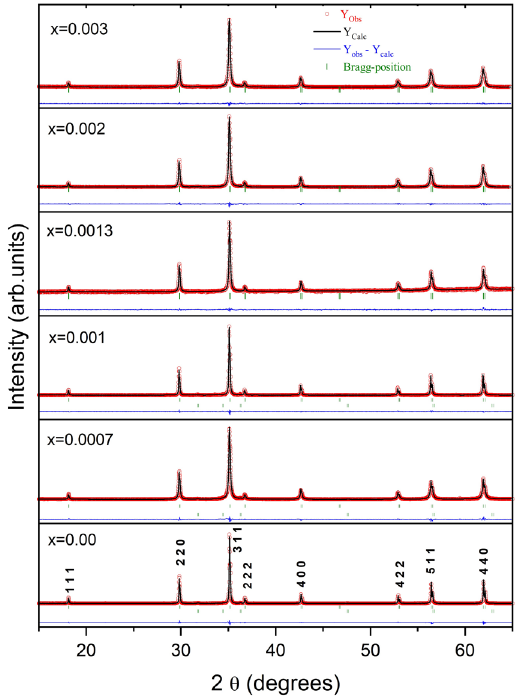
Figure 1. Room temperature X-ray diffraction and Rietveld refinement results of Zn Ni TiO , where x = 0.00, 0.0007, 0.001, 0.0013, 2(1-x) 2x 4 0.002 and 0.003. Bragg positions are related to the Zn and ZnO (bottom)